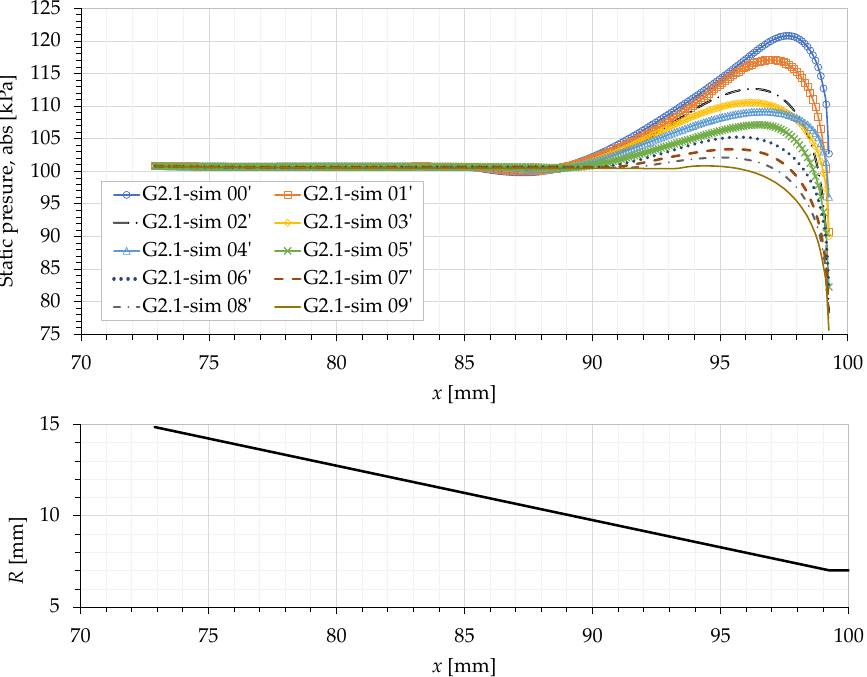
Figure 22. Pressure variation along the wall of the converging mixing section (72.9 ≤ x ≤ 99.259 mm) of ejector G2.1 (top) and the geometrical contour of the converging mixing section wall (bottom). The operating conditions of sim 00’ to 09’ can be seen in Table 5 (correspond to sim no. 0’ to 9’).